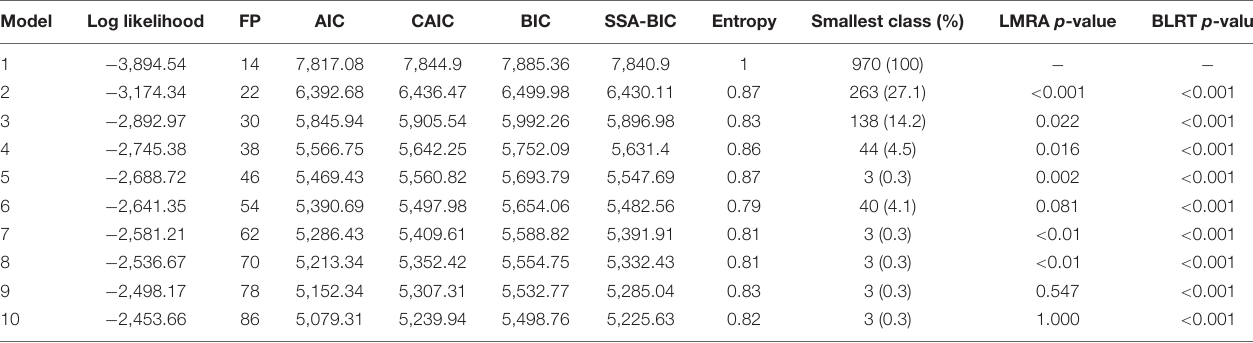
TABLE 2 | Latent profiles analysis model fit summary.